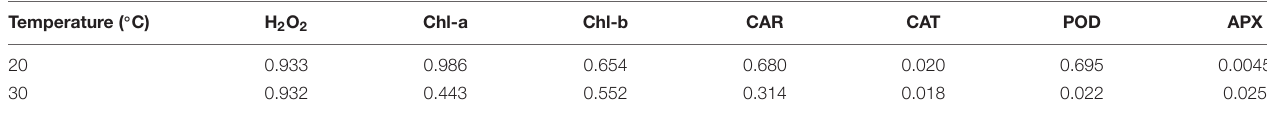
TABLE 6 | p -values for the difference between morning and